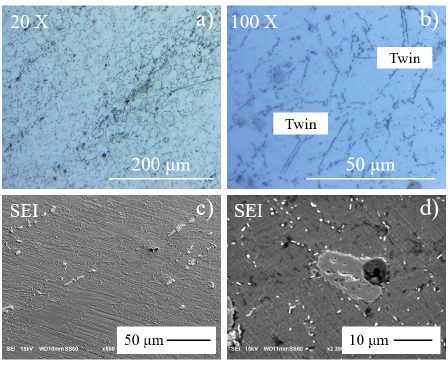
Figure 4. Optical microscope (OM) and scanning electron microscope (SEM) micrographs of aged Inconel 718: ( a , b ) optical micrographs; ( c , d ) scanning electron micrographs.